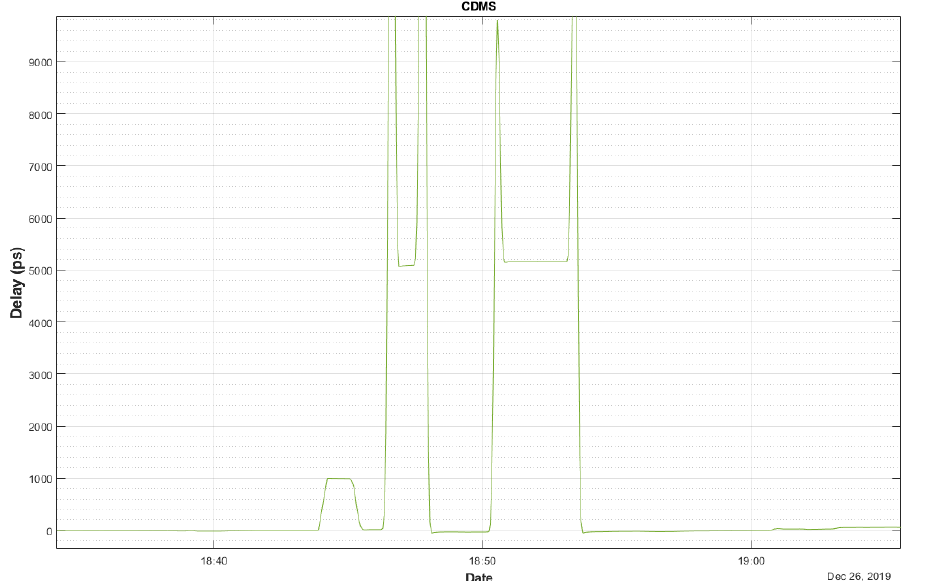
Figure 9. Delay measurements for the phaseCal GU test